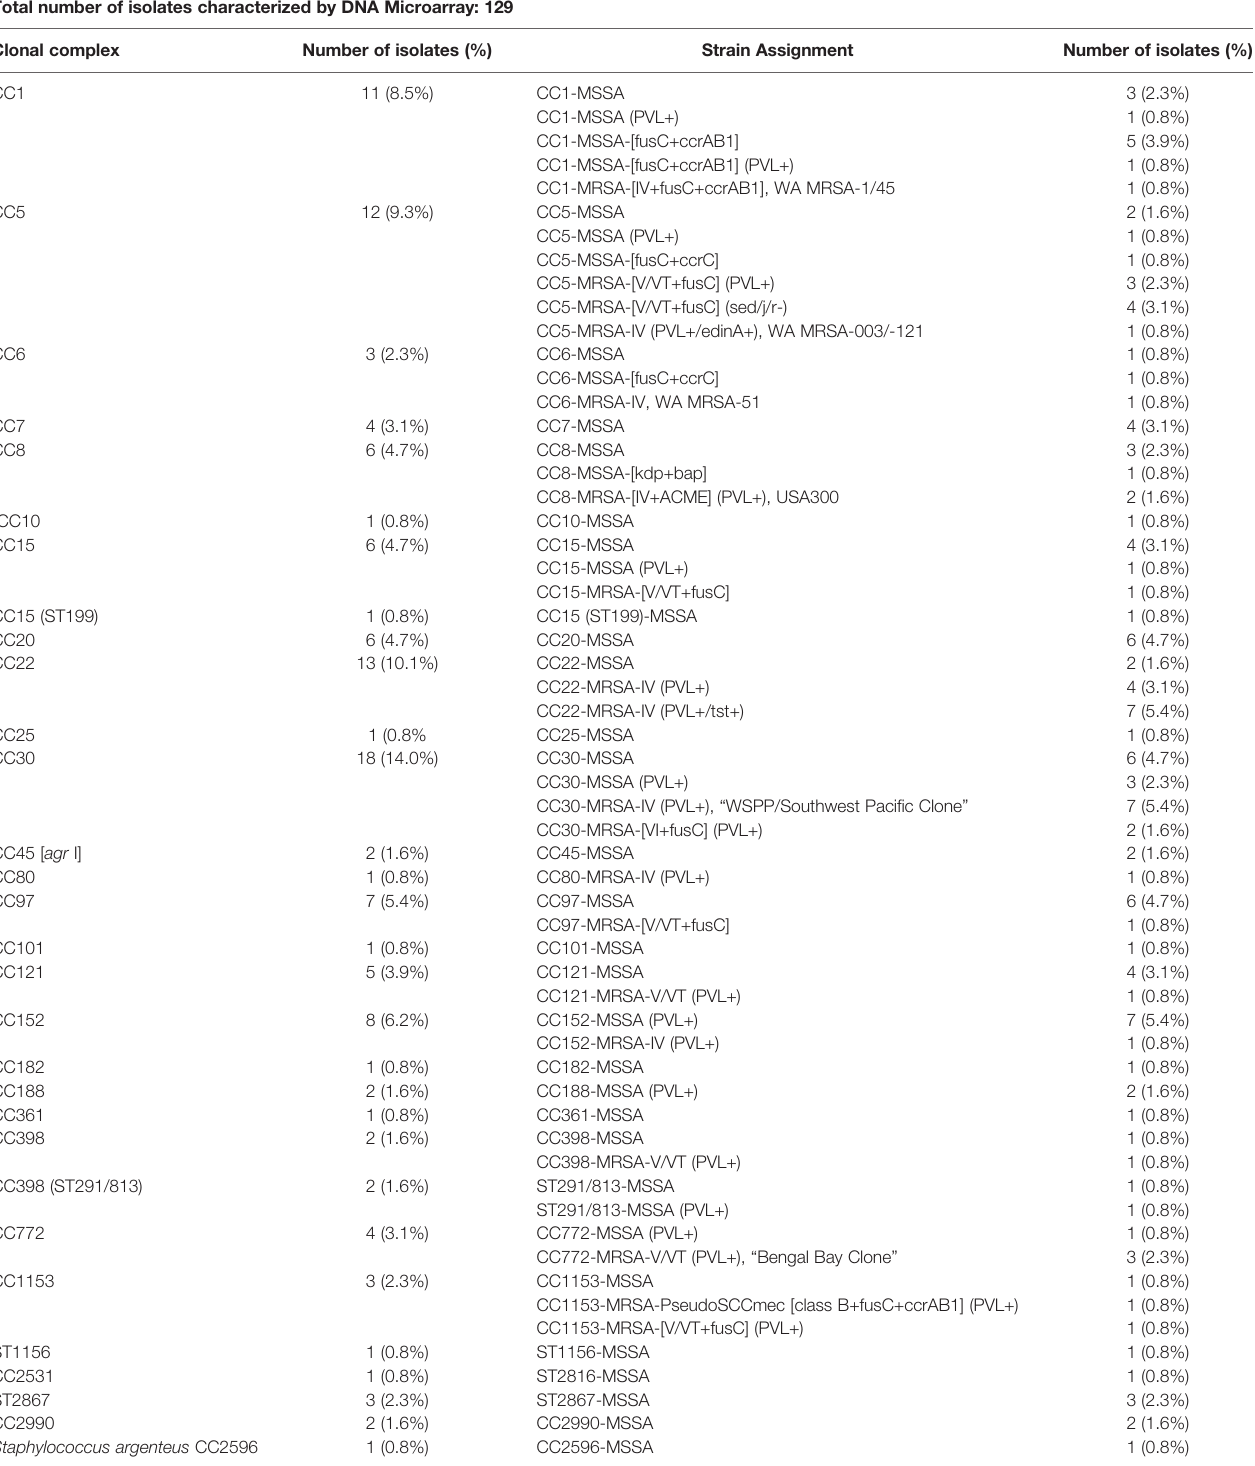
TABLE 2 | Distribution of clonal complexes and strain assignment. Total number of isolates characterized by DNA Microarray: 129 Clonal complex